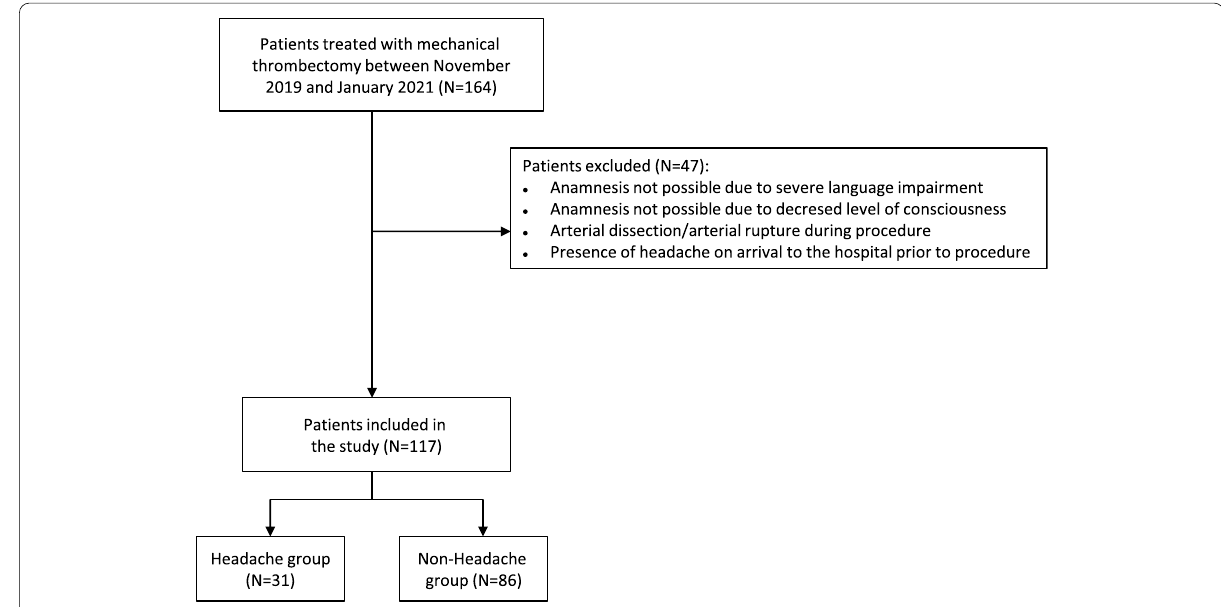
Fig. 1 Flow chart with number of patients included and excluded in the study